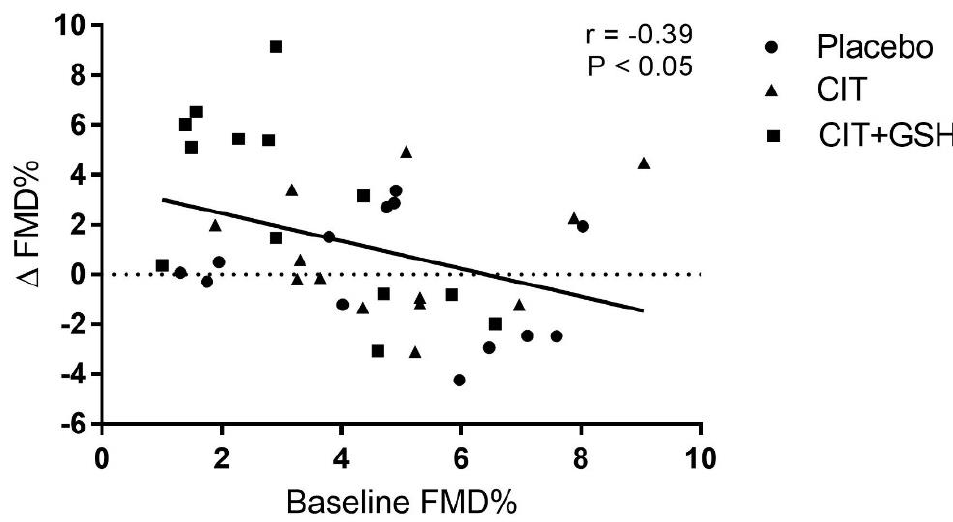
Figure 3. Relationship between changes ( ∆ ) in the brachial artery flow-mediated dilation ( ∆ FMD%) from 0 to 4 weeks and baseline (0 week) FMD%. Abbreviations: CIT, citrulline; CIT+GSH,